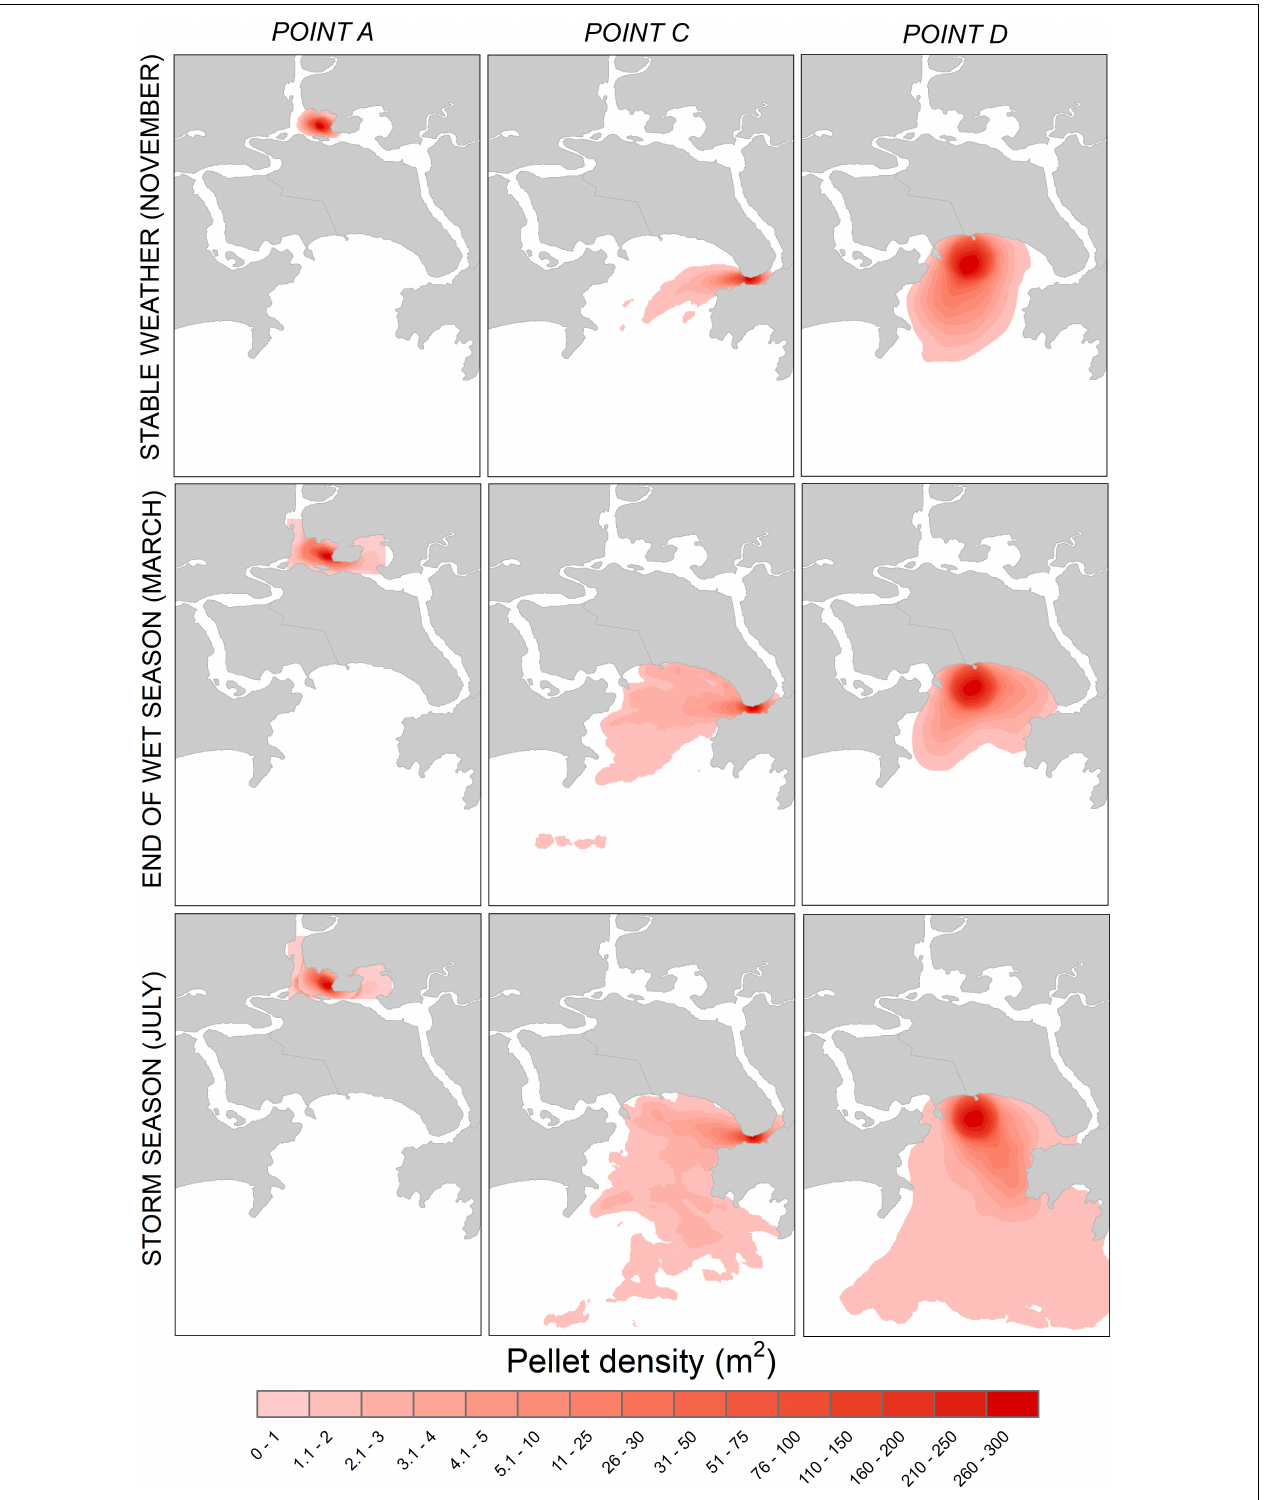
FIGURE 2 | Dispersal simulations for plastic pellets during the stable weather conditions of November (top), the end of the rainfall period (March, middle) and the period of peak sea storm activity during June (bottom) considering 5 different release points within the SES and coastal waters of Santos Bay. Polygons show the area of dispersal, with the color ramp indicating the number of accumulated particles predicted using a “density plot” function that calculates a magnitude-per-unit area (m 2 ) from points using a kernel function to fit a smoothly tapered surface to each point.